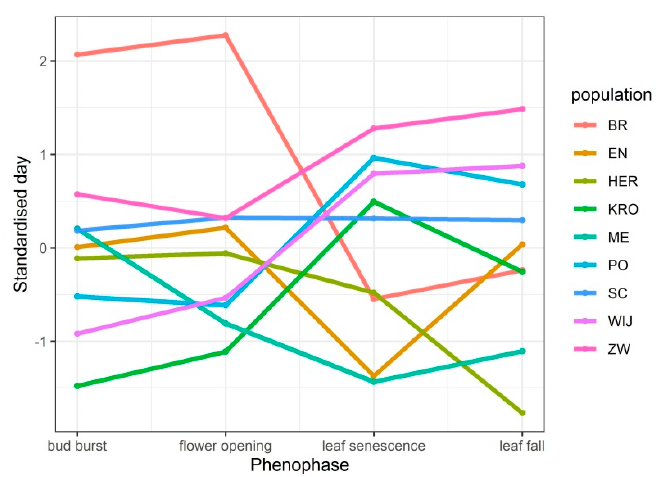
Figure 4. Order of the modelled timing of bud burst, flower opening, leaf senescence and leaf fall for the different sampled populations in the plantation of Dentergem. Standardized days were calculated for which half of the plants of a population had reached a score of 4 or higher (bud burst and flower opening), had reached a score of 2 or lower (leaf senescence) or had reached a score of 3 or lower (leaf fall). Population abbreviations are in Table 1. Table 4. Pearson correlation coefficients and corresponding p values between the four phenophases (Dentergem). Bud Burst Flower Opening Leaf Senescence r p Value